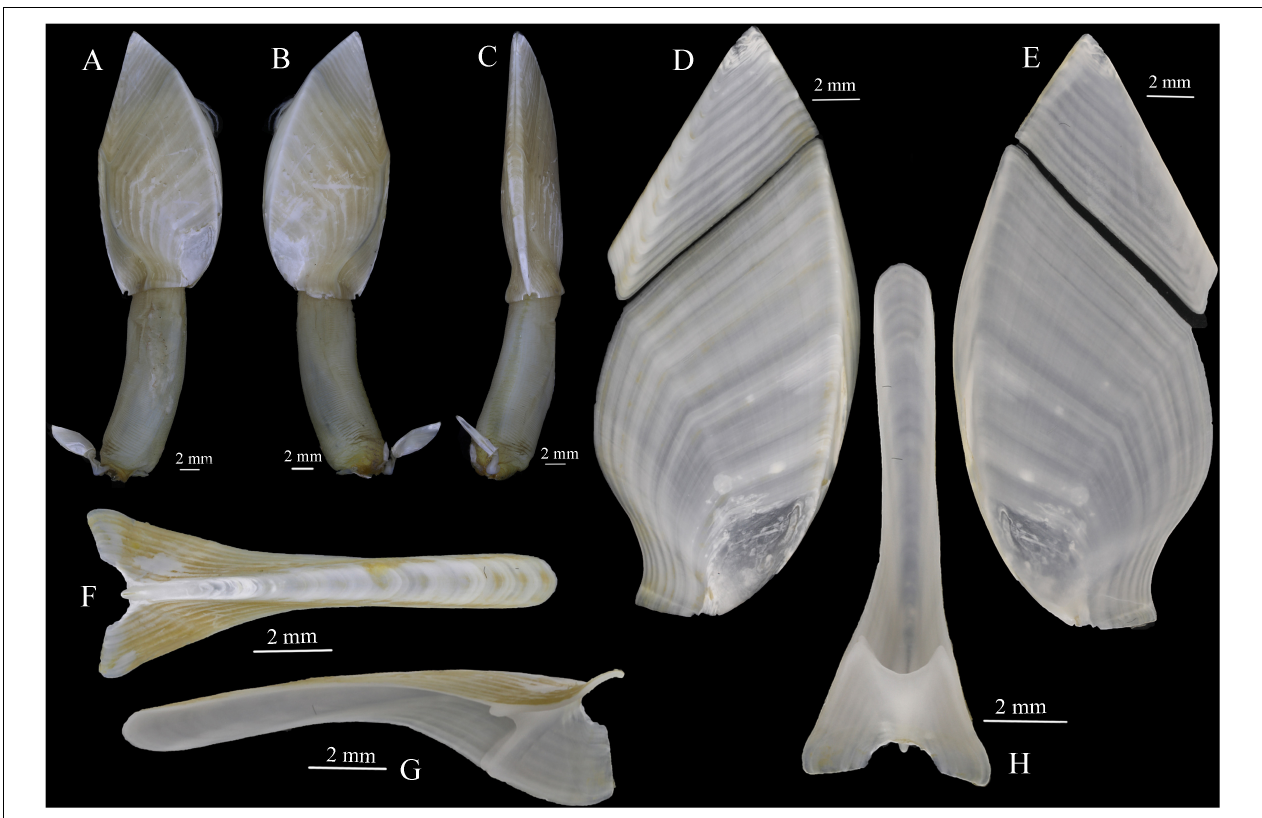
FIGURE 5 | Glyptelasma robustum sp. nov. holotype. (A,B) Lateral views. (C) Carinal view. (D) Exterior view of tergum and scutum. (E) Inner view of tergum and scutum. (F) Exterior view of carina. (G) Lateral view of carina. (H) Inner view of